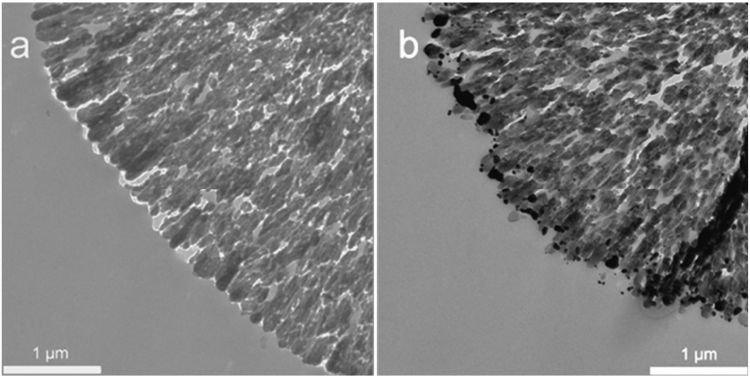
Figure 3. TEM images of: ( a ) CaCO 3 microcrystal; ( b ) Au NPs/CaCO 3 hybrids obtained by Au NP adsorption followed by the reduction of HAuCl 4 (method 3) before the elimination of CaCO 3 . Bovine serum albumin (BSA) was used as a probe to evaluate the SERS performance of the one-component Au microshells at characteristic modes of albumin (~1130 cm −1 , ~1180 cm −1 , ~1210 cm −1 , and ~1345 cm −1 [35]). The Raman spectrum of pure BSA was rec- orded at different laser powers, starting from 0.4 µW until the characteristic modes of BSA were recorded with sufficient resolution (40 mW); these boundary spectra are shown in Figure 4. The Raman spectra of the obtained one-component porous Au microshells in water dispersion have typical modes for the DMAP used for the stabilization of Au NPs [36]). The same peaks are observed in SERS spectrum of BSA obtained in its dispersion with porous SERS platforms. Corresponding characteristic peaks of the analyte are shown in SERS spectrum with the grey lines (Figure 4). SERS spectra were recorded at minimum 0.4 µW laser power and provide solid evidence of a very high sensitivity of the obtained pure porous Au-based microshells as SERS platfor ms.